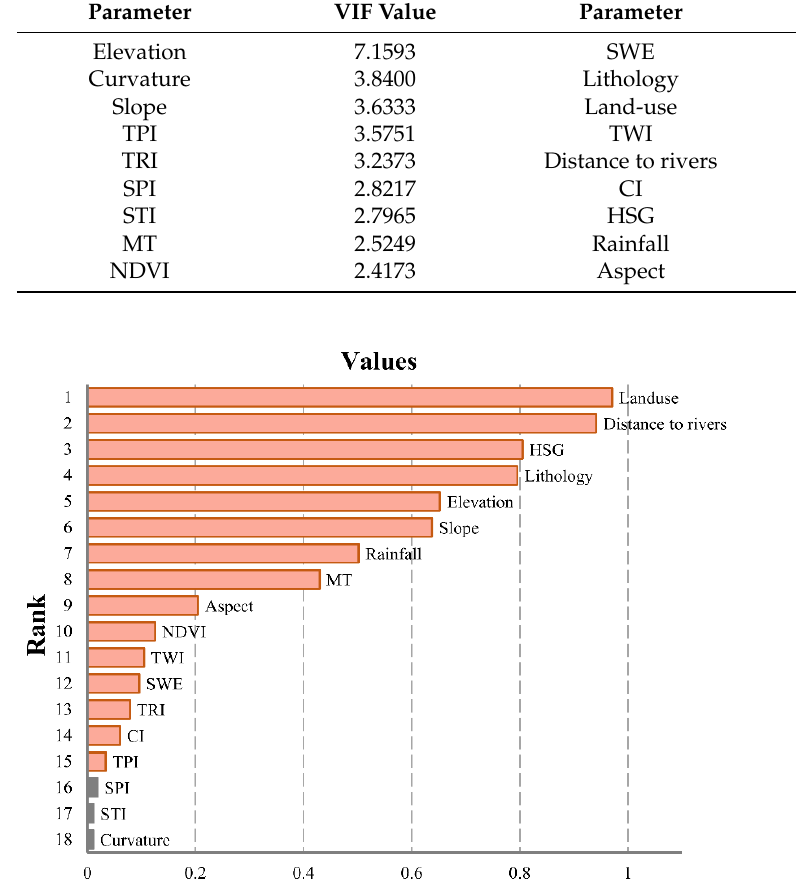
Table 3. The result of the multicollinearity test (VIF).